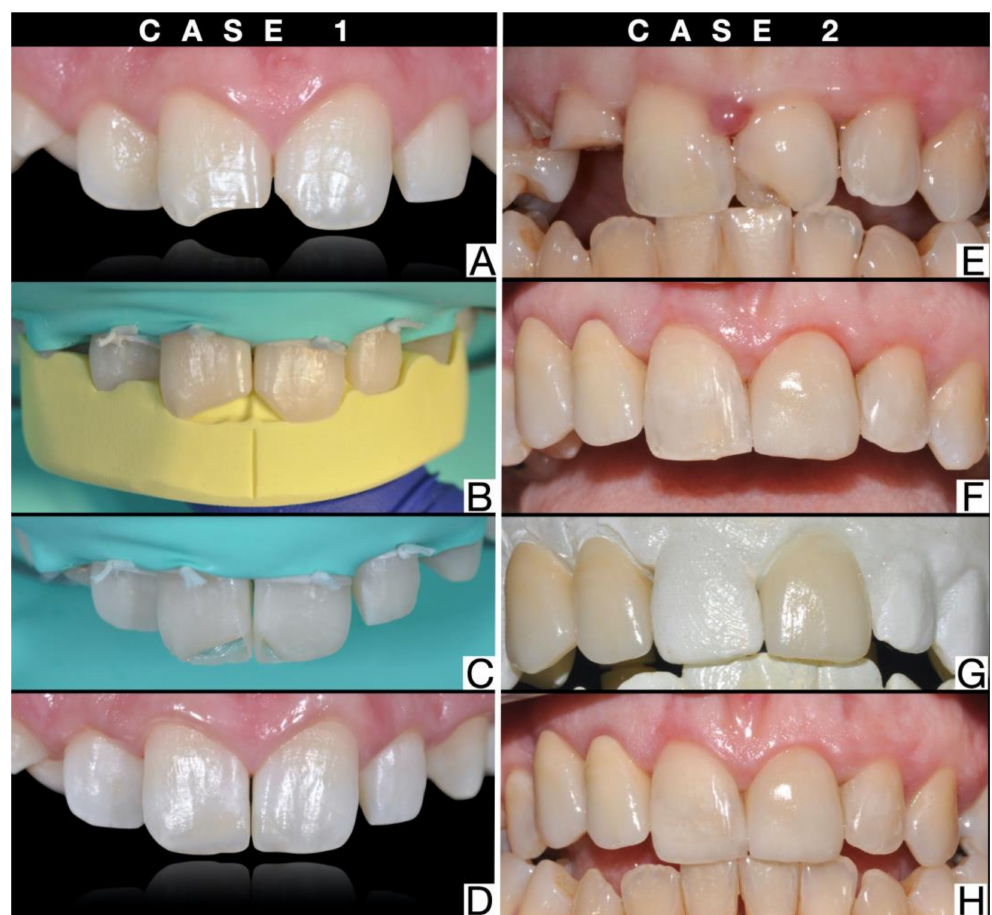
Figure 1. Case 1: ( A ) image after trauma of 1.1 and 2.1, ( B ) silicone guide, ( C ) first palatal increment, and ( D ) final restoration. Case 2: ( E ) image after trauma of 2.1, 1.2, and 1.3; ( F ) provisional resin crow; ( G ) prototyped models; and ( H ) final